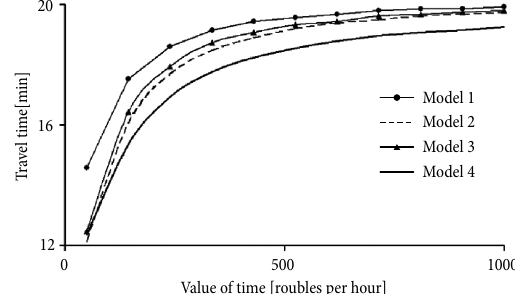
Fig. 6. Influence of value of time on total costs